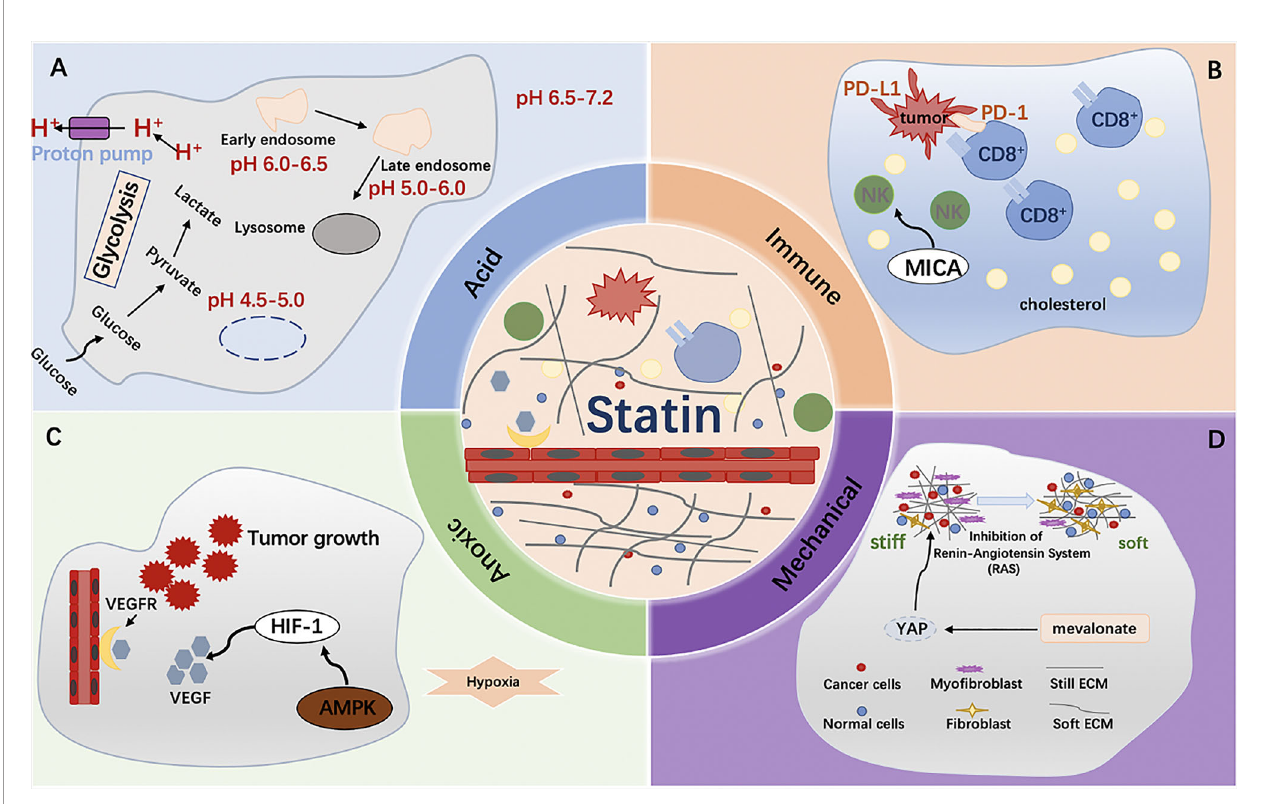
FIGURE 4 | (A) Fatty acid synthesis increases along with the accumulation of H+, which contributes to the generation of acidic tumor microenvironment. Statins signi fi cantly reduced plasma free fatty acid concentrations; (B) Tumor microenvironment was rich in cholesterol and that cholesterol induced immune checkpoint expression and failure of CD8 + T cells, and statin lowers PD-1 expression in CD8+ T cells and effectively restores antitumor activity; (C) HIF-1 a plays a central role in the carcinogenesis and progression of cancer, and can promote the proliferation, invasion and metastasis of tumor cells. In breast cancer, simvastatin activation of AMPK suppresses breast tumor angiogenesis by blocking HIF-1 a -induced pro-angiogenic factors; (D) Activation of YAP can control the expression of various cytoskeleton regulatory factors, harden the surrounding matrix of fi broblasts, and promote the invasion of cancer